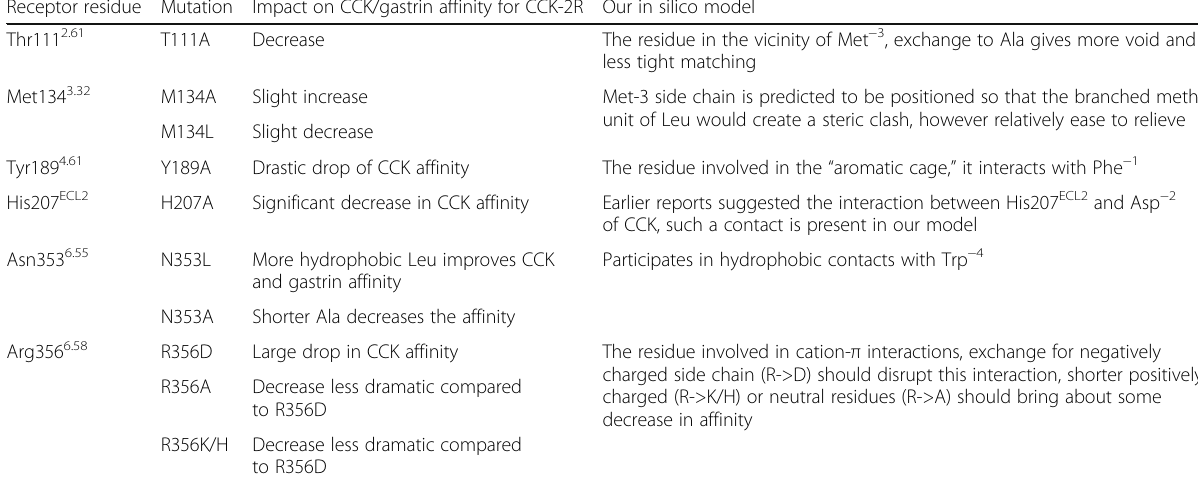
Table 4 CCK-2R mutagenesis data and their correspondence to our model (ref. [27] and references therein) Receptor residue Mutation Impact on CCK/gastrin affinity for CCK-2R Our in silico